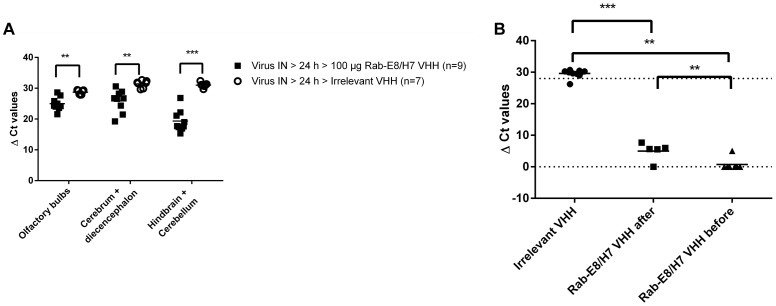
Viral RNA load in the brain after anti-rabies Rab-E8/H7 treatment.(A) Mice were treated with Rab-E8/H7 (100 µg) by intracerebral injection (IC) 24 hours after intranasal virus inoculation and sacrificed at 7 DPI to assess the viral RNA loads in different brain parts. Rab-E8/H7 VHH treatment significantly reduced the spread of the virus from the front to the posterior parts of the brain (t-test, ** p<0.01, *** p<0.0001). (B) Mice were treated with Rab-E8/H7 at 24 hours before (0.12 µg) or after (100 µg) intranasal virus inoculation. Control mice were mock-treated with irrelevant VHH before virus inoculation. Viral RNA loads were measured at 35 DPI in the brain of survivor mice. Four out of five survivor mice, treated after the virus inoculation, showed residual traces of viral RNA in the brain (ΔCt 5±2.9; *** p<0.0001). These mice had however never developed signs of disease. All mock-treated mice had to be euthanized at 7–9 DPI, because of serious disease, which coincided with high viral RNA loads in their brains (ΔCt≥28).